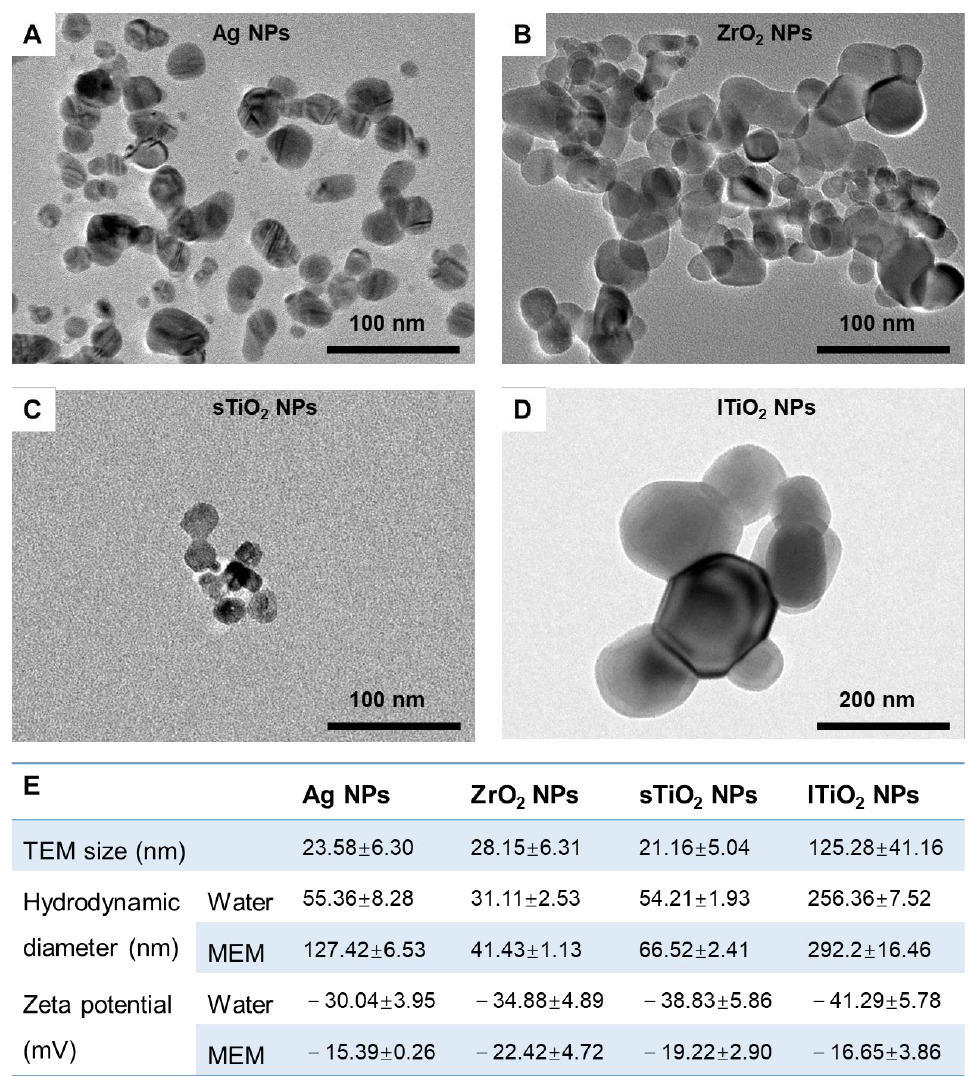
Figure 1. Characterization of MNPs. ( A – D ) TEM graphs of Ag NPs ( A ), ZrO 2 NPs ( B ), small-sized TiO 2 (sTiO 2 ) NPs ( C ), and large-sized TiO 2 (lTiO 2 ) NPs ( D ). ( E ) Summarized characteristics of these four MNPs, including TEM size, hydrodynamic diameter, and zeta potential in DI water and MEM cell culture medium supplemented with 10% fetal bovine serum (FBS). In ( E ), data are shown as means ± s.d., n = 3.